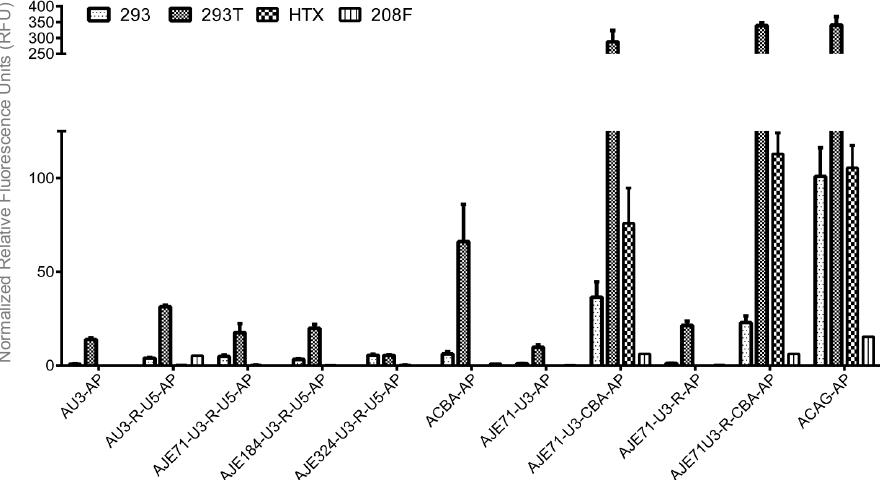
Figure 3. Transfection of four different cell lines (HEK 293, HEK 293T, 208F, and HTX) with various